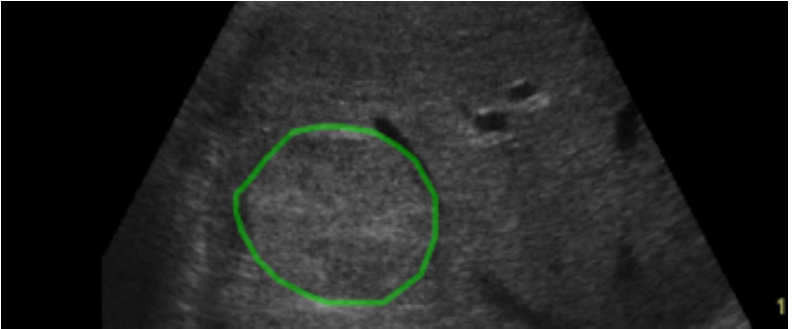
Figure 1. The visual aspect of HCC in ultrasound images: the HCC contour is marked with